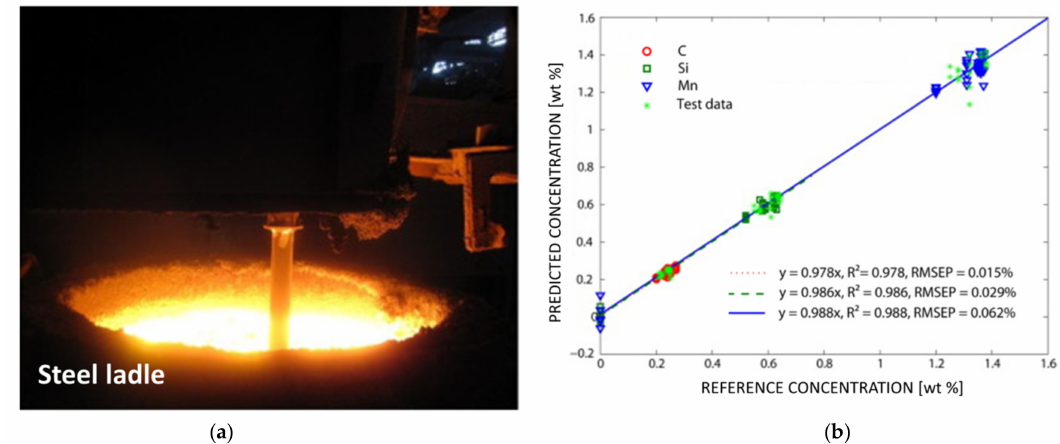
Figure 9. LIBS in-line measurement of molten steel. ( a ) Photograph of the LIBS system refractory lance that is immersed into the liquid steel in the ladle. ( b ) Calibration and test results for C, Si, and Mn of liquid steel in a steel plant (straight lines: linear fits to data). Adapted from